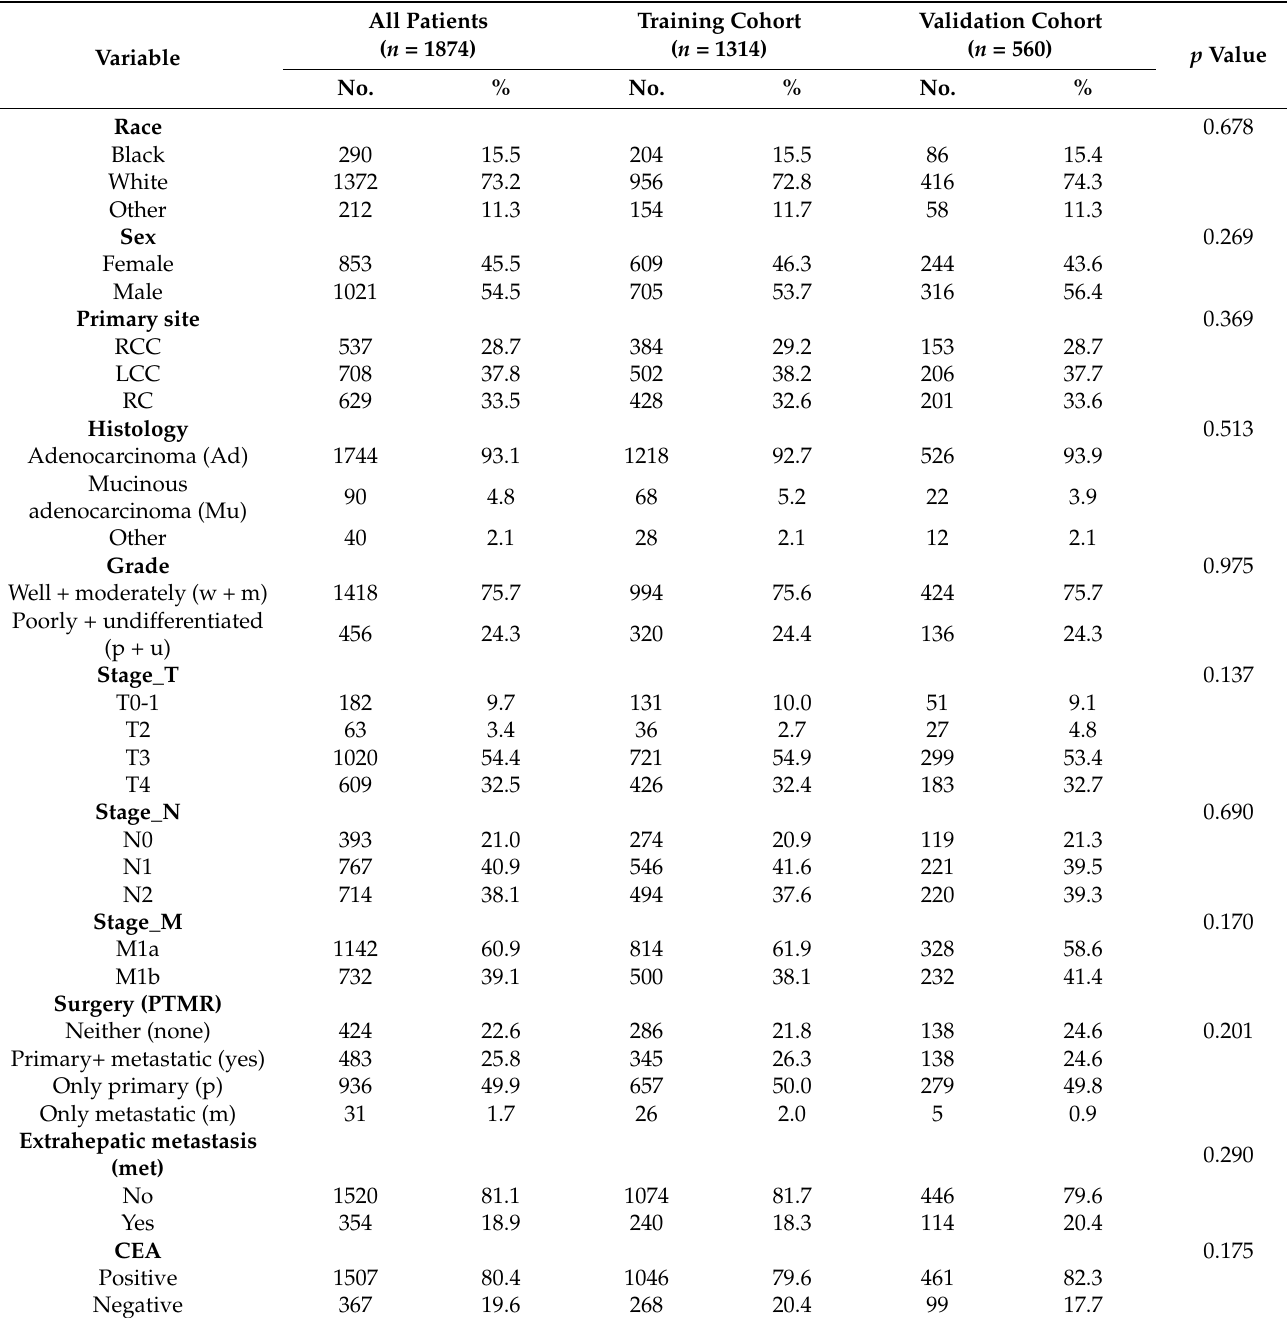
Table 1. Patient demographics and pathological